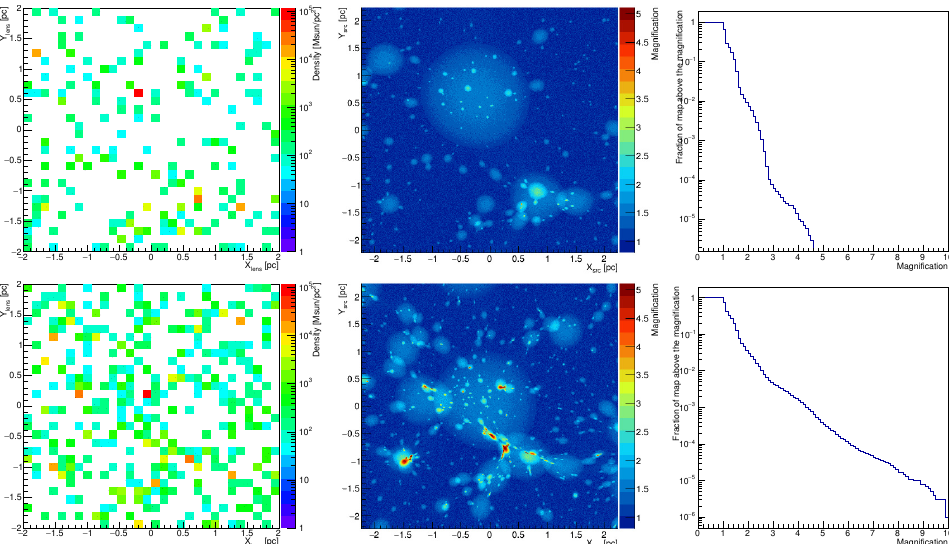
Figure 1. Microlensing by a giant molecular cloud (GMC) with M GMC = 2 × 10 5 M (cid:12) , R GMC = 20pc composed of homogeneously distributed clumps (top panels) or a distribution of clumps in the GMC following dN clump / dV ∝ r − 1 (bottom panels). Left panels: surface density (in the reference frame of the lens) of the mass of the lens, with individual clumps marked with black points. Middle panels: magnification map in the reference frame of the source. Right panels: fraction of the map with a magnification above a given value. Individual panels reproduced from